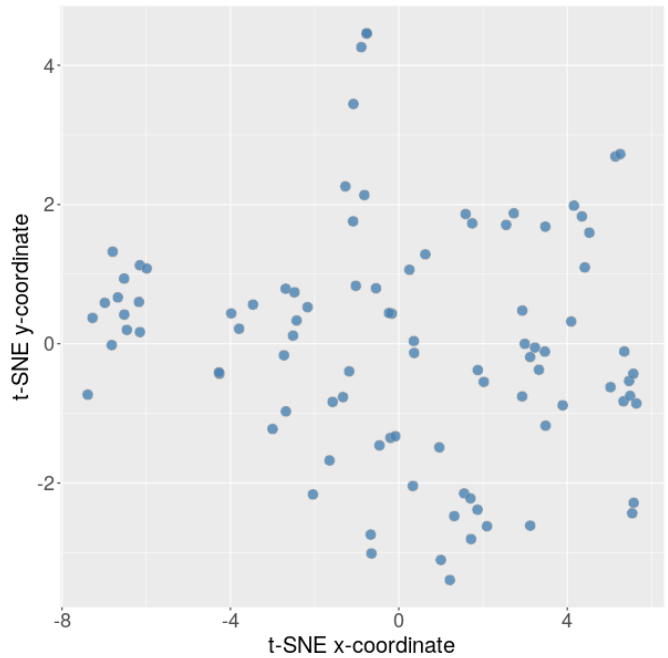
Figure 14. Two-dimensional embedding of the days in the dataset, using t-distributed Stochastic Neighbor Embedding (t-SNE). Each point corresponds to a day. The x - and y - coordinates are computed by t-SNE, so that nearby points correspond to days that are similar with respect to their KPIs. We can see that groups of similar days